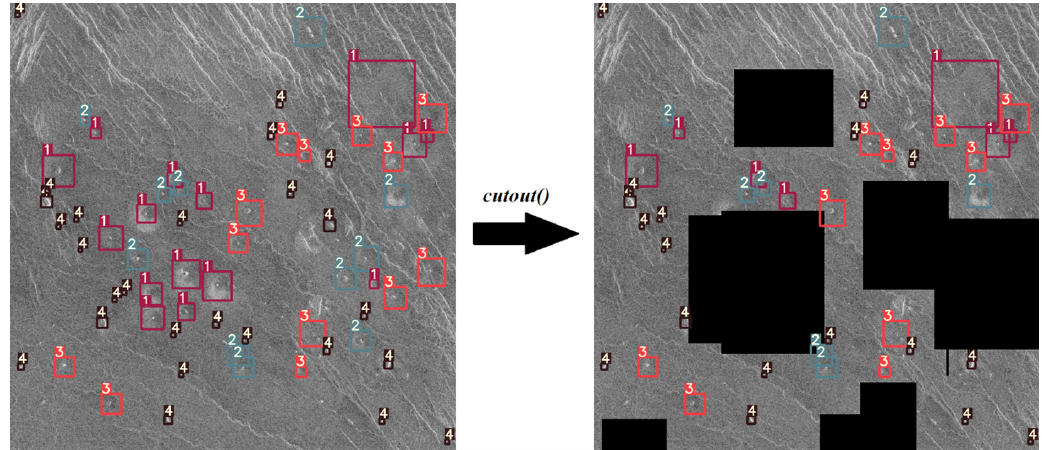
Figure 11. Example of an cutout